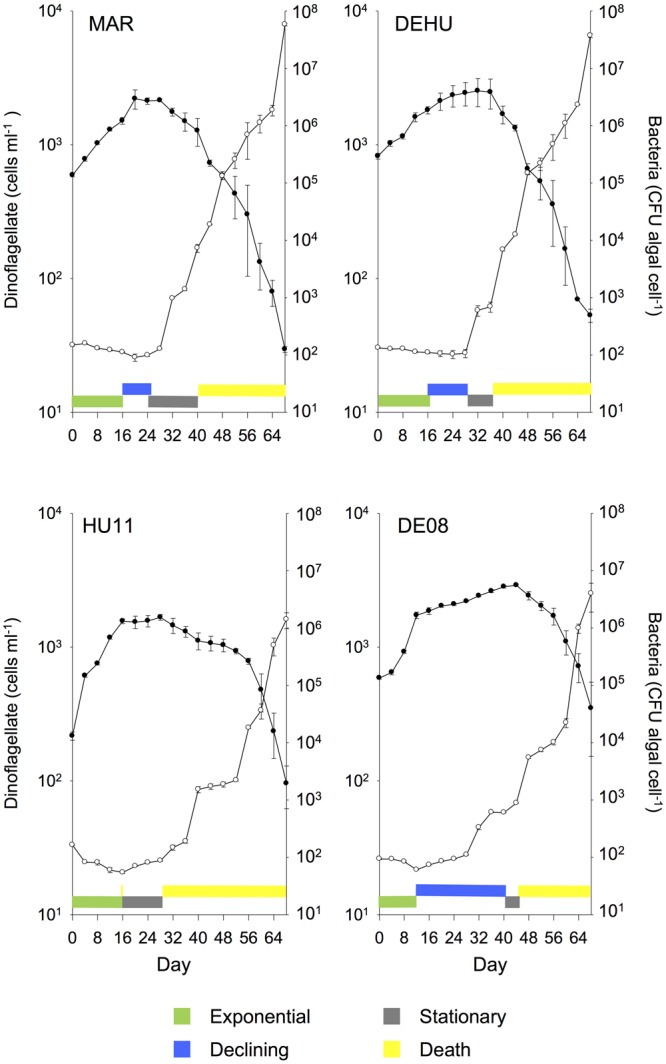
Mean (± SE) batch culture growth curves of G. catenatum (closed circles) and total bacteria (CFU algal cell-1, open circles) from duplicate cultures grown with three-way combinations of bacterial associates compared to mixed culture community co-cultures and parent cultures (MAR, Marinobacter DG879, Alcanivorax DG881 and Roseobacter DG874; DEHU, mixed bacterial community from non-axenic GCHU11 and GCDE08 parent cultures; GCDE08, GCHU11, clonal non-axenic parent cultures). See Table 1 for culture codes and additional details.